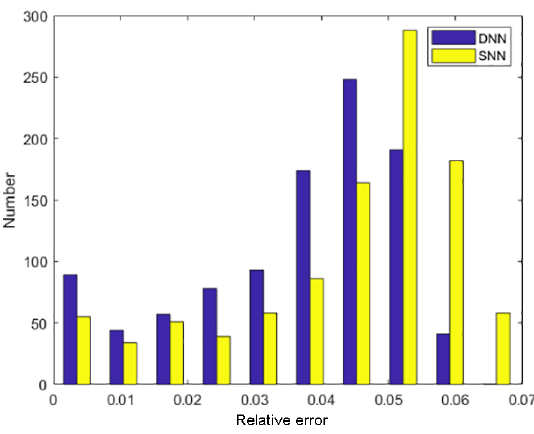
Figure 10. The histogram of the relative error of the shallow neural network (SNN) and deep neural network (DNN).